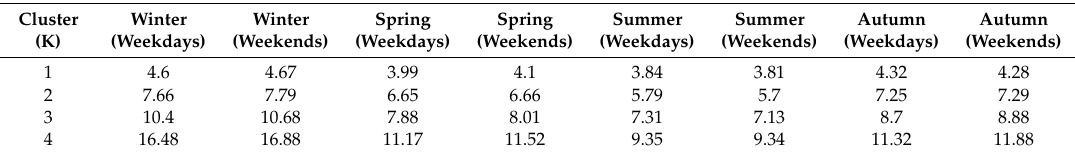
Table 3. Daily average electricity consumption (kWh) by season, weekdays, and weekends for the four